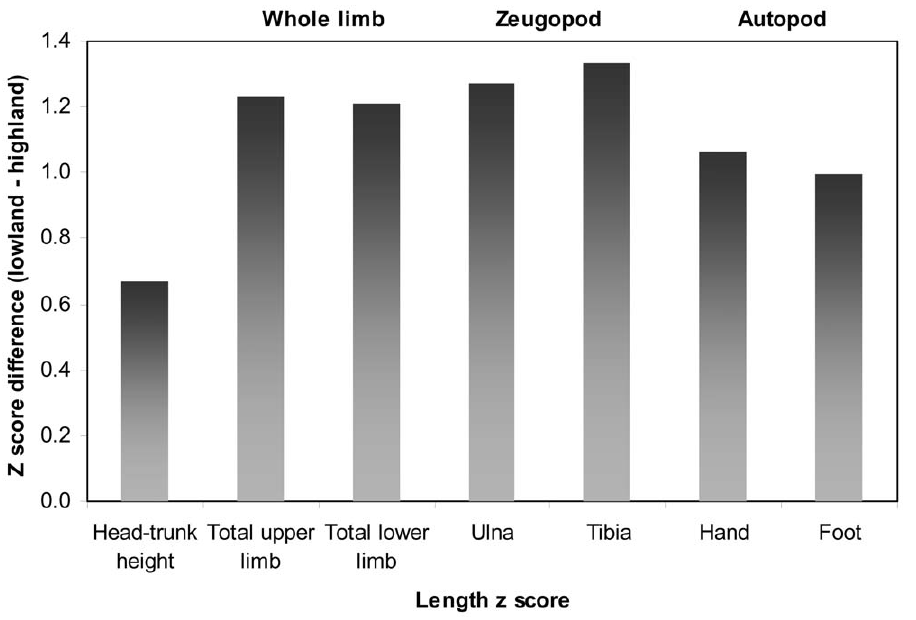
Figure 2. Site differences in estimated marginal means for length z scores from the ANCOVA analyses, demonstrating greater contrasts in total limb and zeugopod lengths, intermediate differences in autopod lengths, and the smallest site differences in head-trunk height.